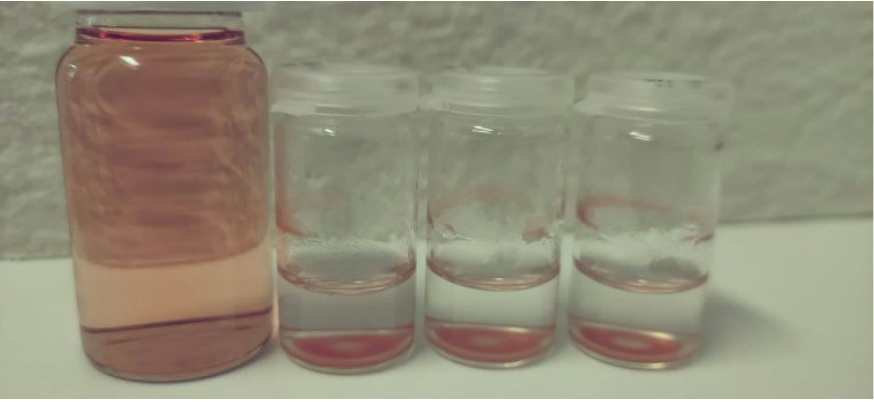
Figure 9. Digital photo of the adsorption of a Cyt C solution onto DCMC. The FTIR spectra of DCMC were obtained before and after being placed in contact with solutions of Cyt C, Lys, α -LA and BSA. Then, the supernatant was removed, and the samples were dried under vacuum overnight. The resulting spectra are presented in Figure 10. Since there were no apparent changes regarding the spectra of DCMC after contact with the buffer solution, α -LA and BSA, the premise that adsorption did not occur in these conditions is supported. However, after adsorption of the positively charged proteins (Cyt C and Lys), there was a change in the absorption band of the